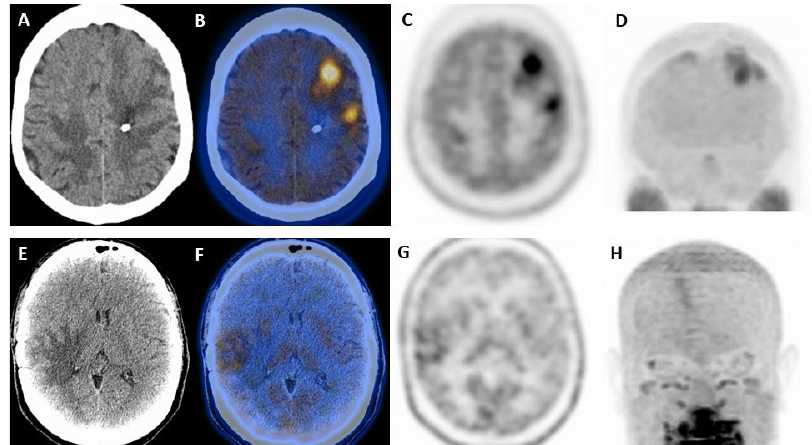
Figure 1. Comparison of two patients with brain metastases investigated with [ 11 C] - MET PET/CT. ( A – D ) Frontal brain metastases from breast cancer (SUVmax 6.4; normal brain 2.5) confirmed on PET/CT; ( E – H ) Radionecrosis in a patient with brain metastasis from melanoma previously treated with radiotherapy (SUVmax 1.97; normal brain 1.27). ( A , E ) low - dose CT; ( B , F ) fused axial PET/CT; ( C , G ) axial [ 11 C] - MET PET; ( D , H ) MIP (maximal intensity projection) images.